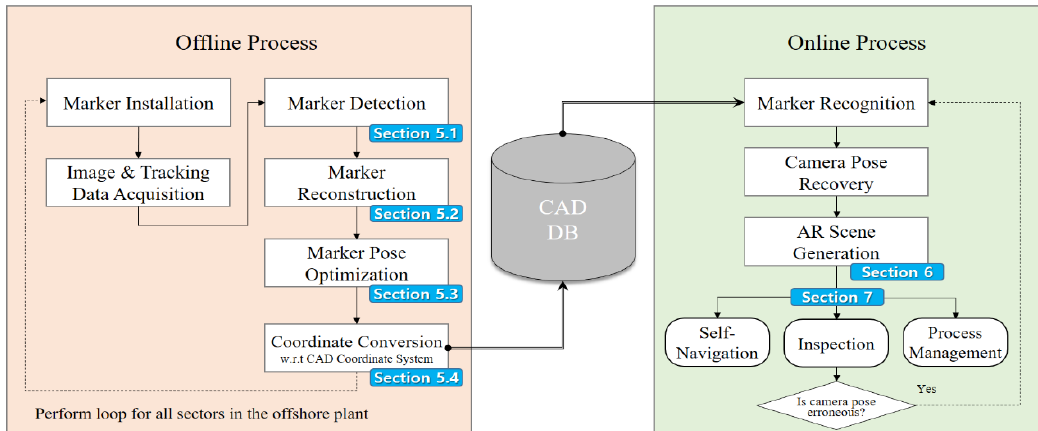
Figure 5. Overview of proposed AR system.